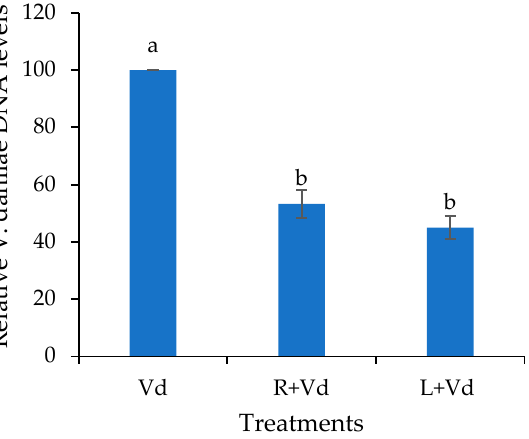
Figure 2. Relative quantification of the V. dahliae DNA levels in wild-type A. thaliana leaf injected (L + Vd) or root drenched (R + Vd) with autoclaved spores of V. dahliae or mock inoculated (positive control, Vd) and inoculated after 3 days with V. dahliae . The relative V. dahliae DNA levels were estimated by qPCR using total DNA isolated from the aerial parts of plants at 25 days post-inoculation. Columns represent means of three biological and technical replications per treatment ( n = 9, ± SE) at 25 dpi (end of pathogenicity experiment). Different letters denote statistically significant differences between treatments ( p < 0.05) according to LSD test.